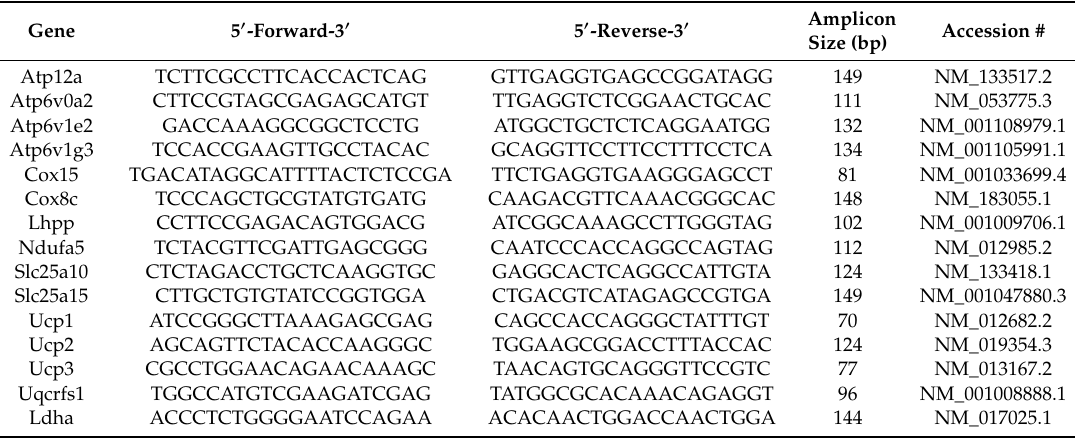
Table 2. Oligonucleotides used for the validation of the identified burn-stimulated mit gene expressions.